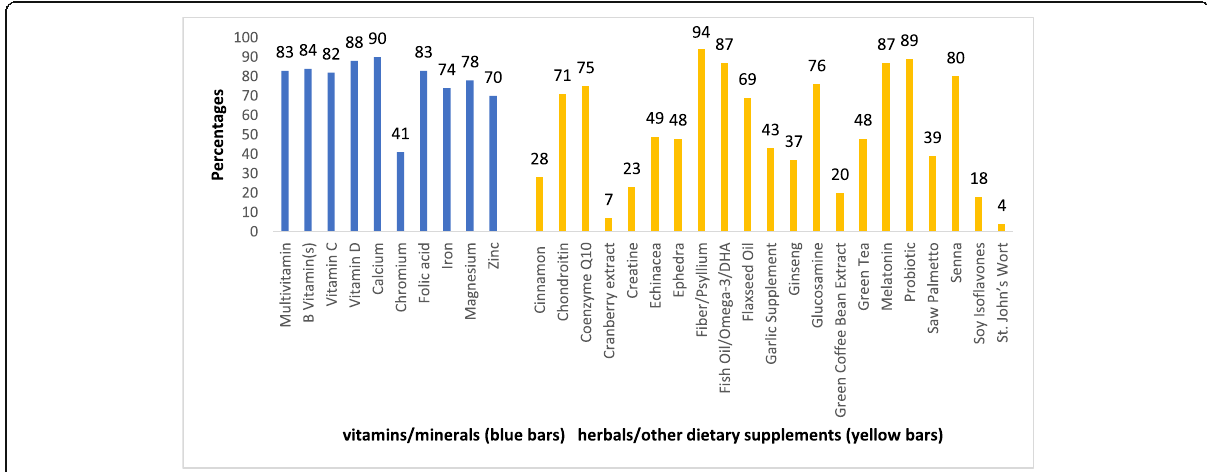
Fig. 3 Percent of pharmacists recommending vitamin/mineral and herbals/other dietary supplements to patients, family and